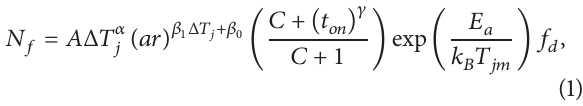
Figure 9: Flowchart of the mission profile based reliability analysis approach for transformerless PV